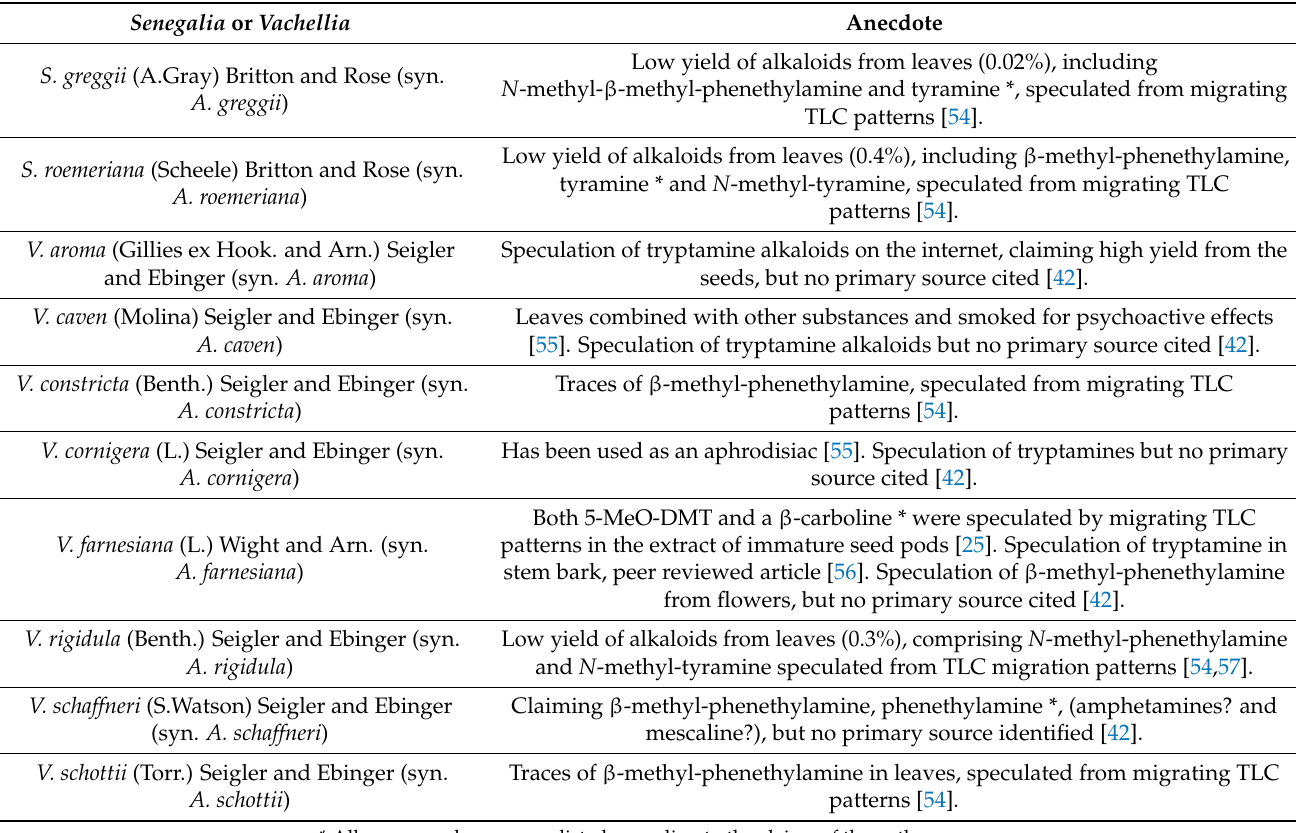
Table 4. American species of Senegalia and Vachellia with tentative or speculative records of psy- chotropic